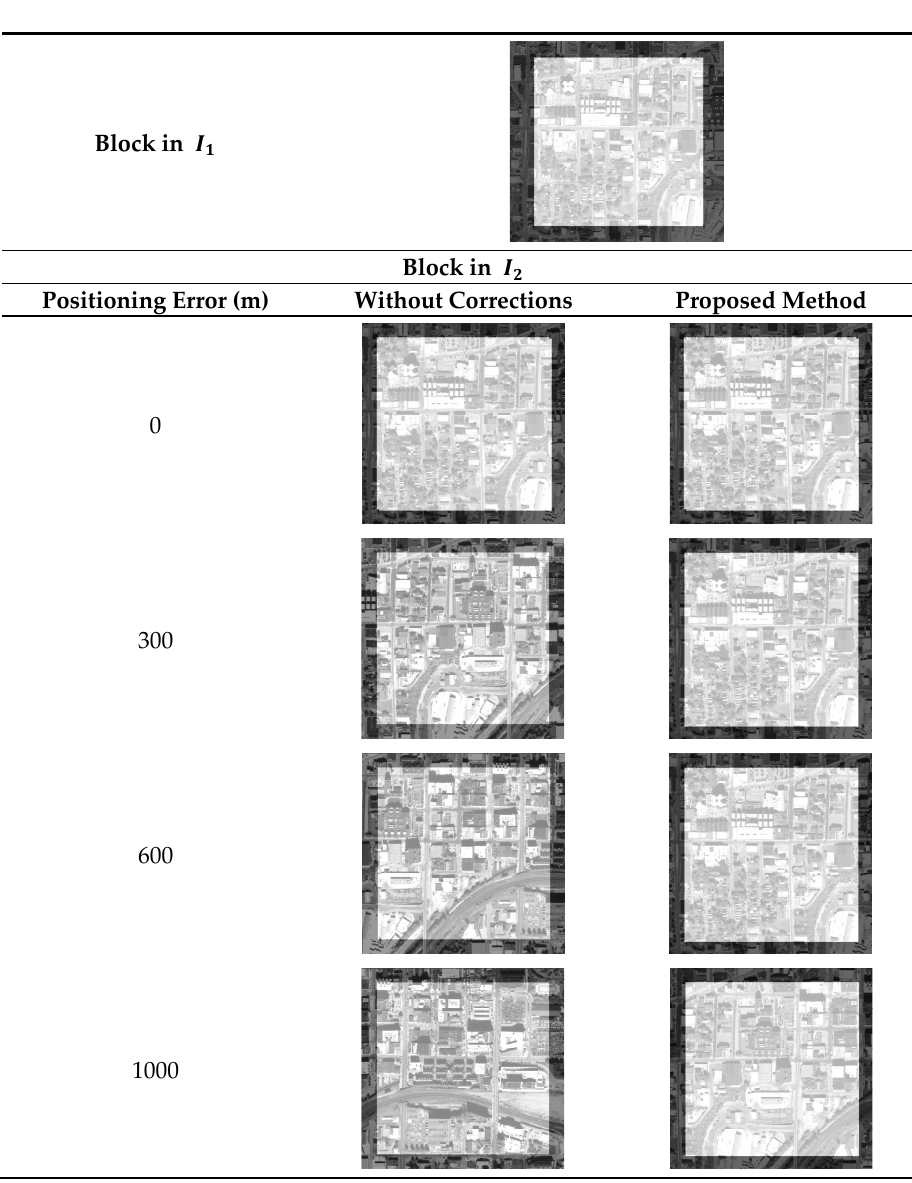
Figure 8. Visual comparisons with/without positioning error corrections.